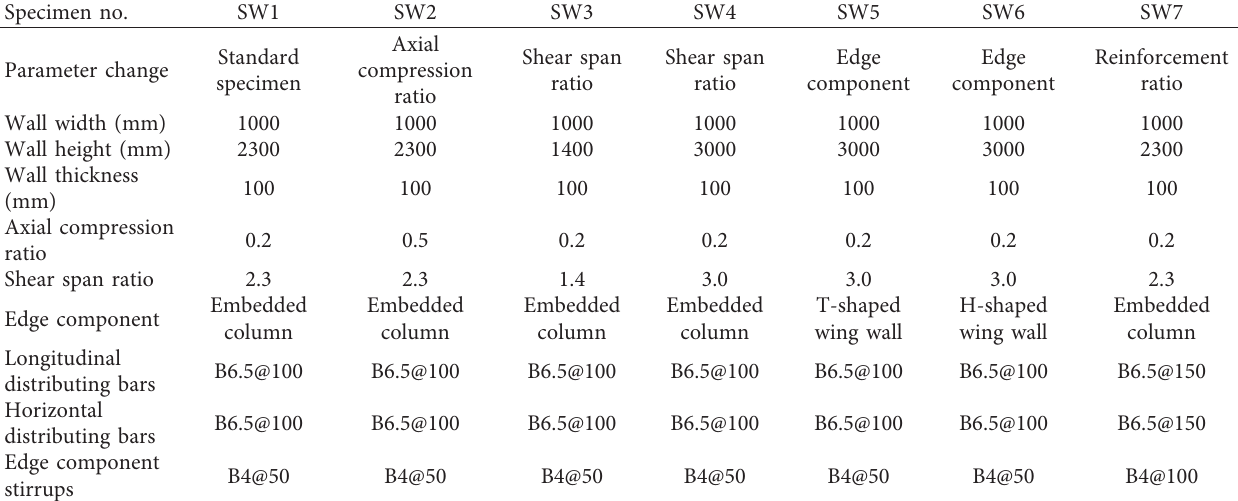
Table 1: Design parameters of the shear wall.